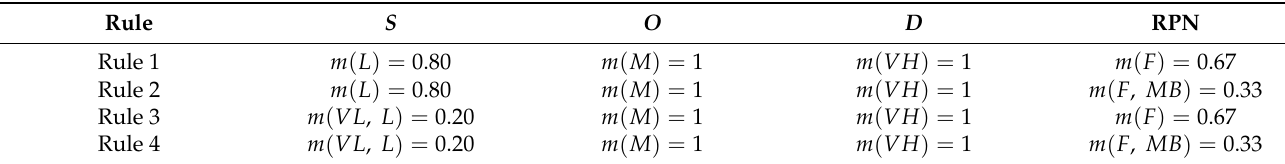
Table 5. Fuzzy ER rules for S = 2, O = 5, and D = 10.